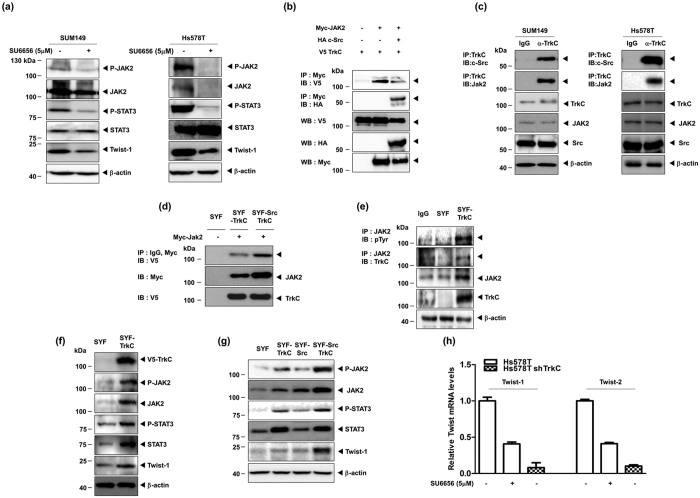
TrkC/c-Src or TrkC interacts with JAK2 and leads to Twist-1 upregulation through activation of the JAK/STAT3 pathway.(a) Western blot analysis of the expression of P-JAK2, JAK2, P-STAT3, STAT3, and Twist-1 proteins in Hs578T and SUM149 cells with or without 5 μM SU6656 treatment for 6 hr. β-actin was used as a loading control. (b) TrkC or TrkC/c-Src complex interacts with JAK2. Immunoblot analysis of whole-cell lysates and immunoprecipitates derived from 293T cells transfected with the V5-TrkC, HA c-Src, and Myc-Jak2 constructs as indicated. (c) Identification of complex formation of endogenous TrkC/c-Src/JAK2 in Hs578T and SUM149 cells. (d) TrkC interacts with JAK2 in SYF-TrkC cells or SYF-Src-TrkC cells after transfection with Myc-Jak2. (e) Activation and expression of Jak2 in SYF cells or SYF-TrkC cells after immunoprecipitation was examined by immunoblotting using the indicated antibodies. (f) Western blot analysis of the expression of P-JAK2, JAK2, P-STAT3, STAT3, and Twist-1 proteins in SYF cells or SYF-TrkC cells. (g) Western blot analysis of expression of P-JAK2, JAK2, P-STAT3, STAT3, and Twist-1 proteins in SYF, SYF-TrkC, SYF-cSrc, and SYF-cSrc-TrkC cells. (h) Expression levels of mRNA encoding Twist-1 and Twist-2 in Hs578T control-shRNA or TrkC-shRNA cells with or without 5 μM SU6656 treatment for 6 hr. 18S mRNA was used to normalize variability in template loading. Data are presented as mean ± standard error of the mean (SEM).